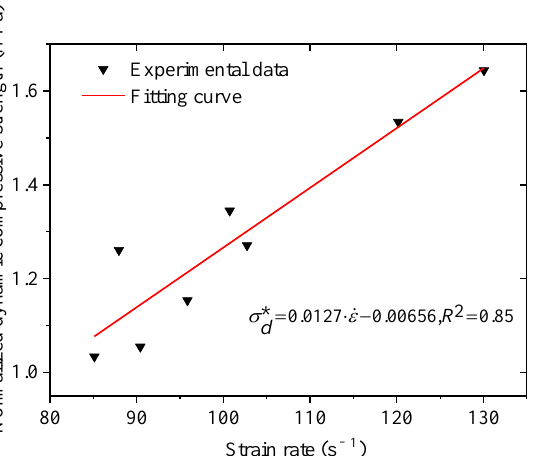
. ε ∗ and for sandstone. d